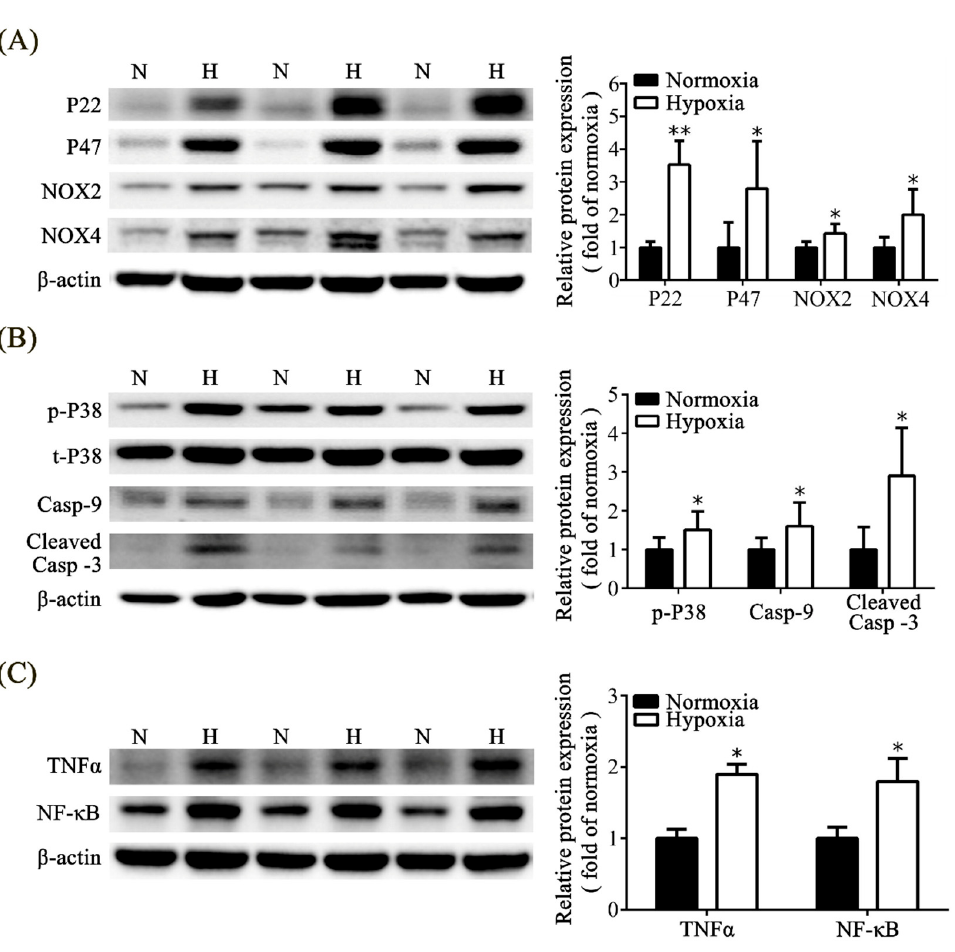
Figure 5. Hypoxic kidney injury involves oxidative stress, apoptosis, and inflammatory signaling. ( A ) Western blot analysis shows the oxidative-stress-related proteins, including P22, P47, NOX2, and NOX4. ( B ) Western blot analysis shows apoptosis-related proteins, including p-P38, Casp-9, and cleaved casp-3. ( C ) Western blot analysis shows the inflammatory-related proteins, including TNF- α and NF- κ B. Quantitative analysis was performed for each blot. The values are presented as mean ± standard deviation. * p < 0.05, ** p < 0.01, versus the normoxic group. The p -values were estimated via Mann–Whitney U test ( n = 6). N, normoxia; H, hypoxia. P22, nicotinamide adenine